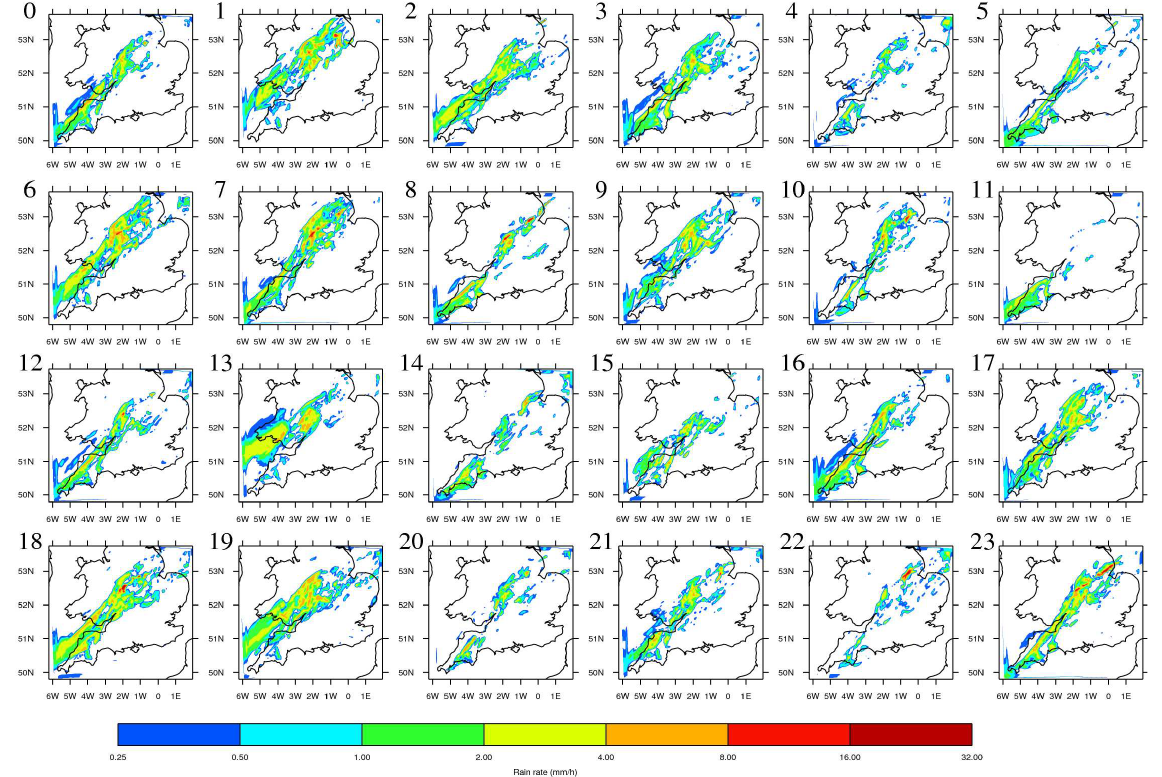
Fig. 8. Control ensemble rainfall rate (mmh − 1 ) at 15:00UTC. The control member (member 0) is in the top left-hand